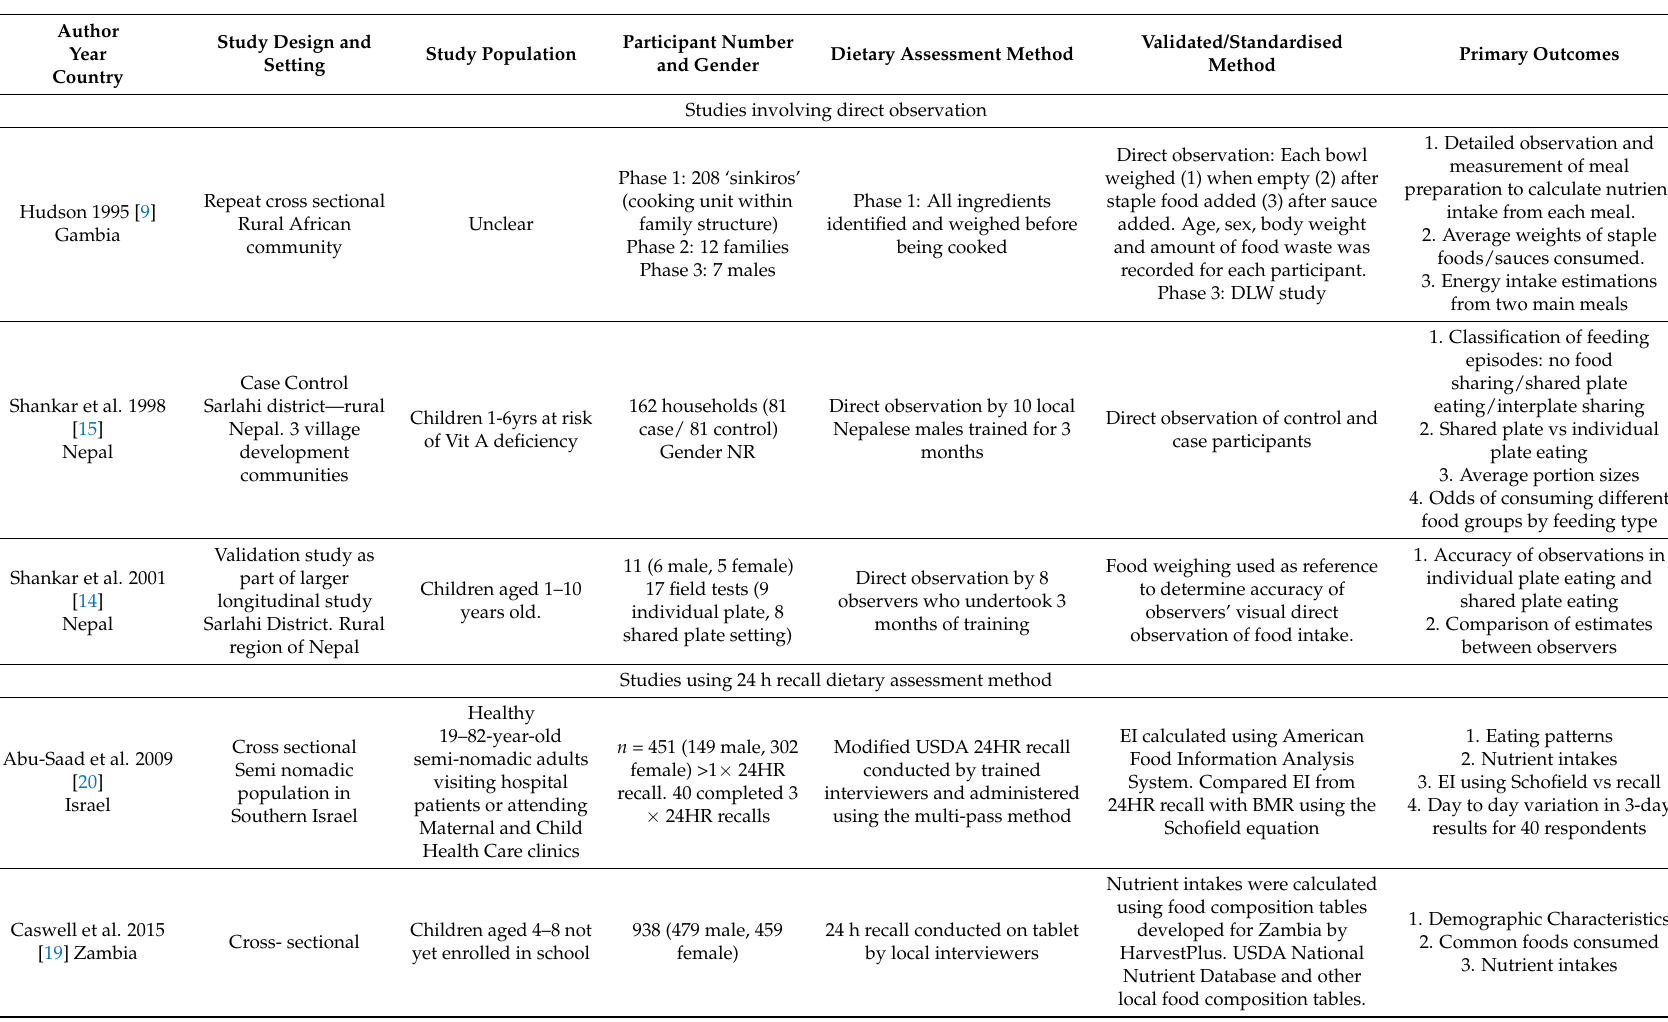
Table 1. Studies investigating shared plate eating in low- and lower-middle income countries (LLMIC) and reported diet, food, or nutrient